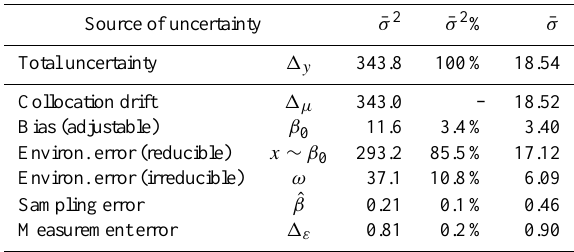
Table 1. Budget of total collocation uncertainty for relative humid- ity (1 rh ) in Beltsville–Sterling, using the HFR model of Eqs. (14) and